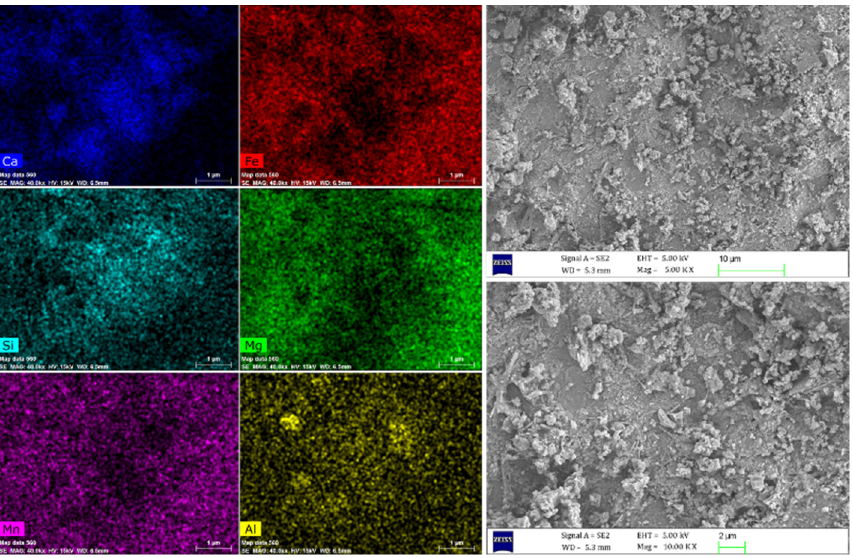
Figure 1. Map-scanning of steel slag surface and SEM results.